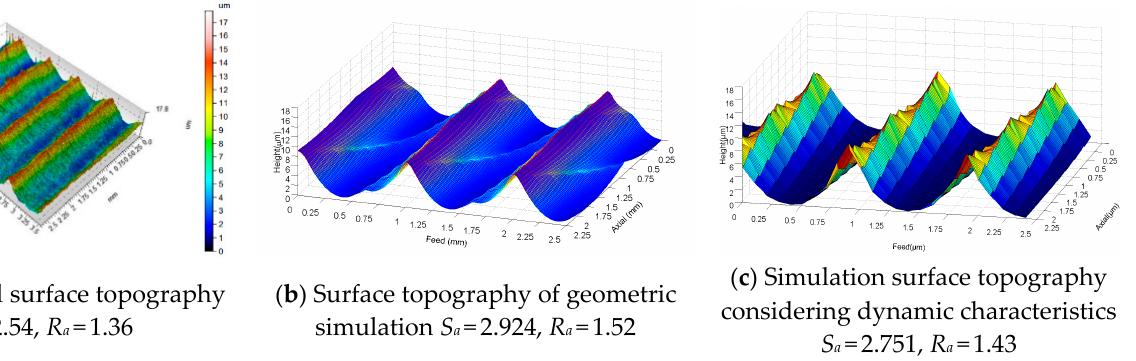
Figure 12. Measurement and simulation results of milling surface topography of ultra-high strength